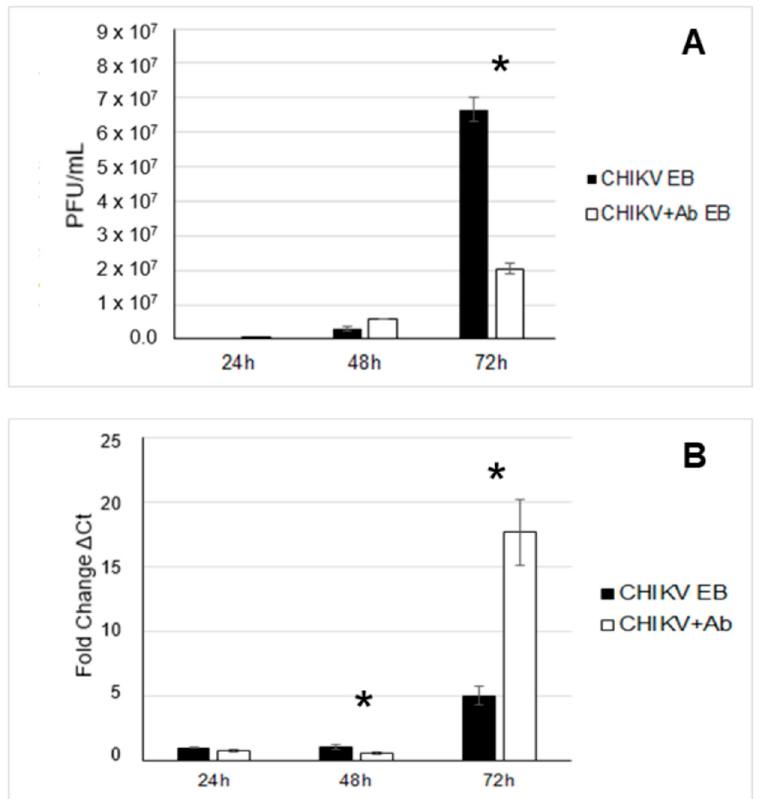
Figure 4. Detection of CHIKV in EBs. ( A ) Viral titration of EBs was performed via plaque assay. Significantly less CHIKV was detected at 72 h p.i. when VEEV antibodies were present ( p = 0.027, n = 6). ( B ) RT-PCR detected significantly more genome copies at 72 h p.i. when VEEV antibodies were present ( p = 0.0267, n = 6), and significantly less at 48 h when VEEV antibodies were present ( p = 0.0103, n = 6). * denotes statistical significance between treatments.